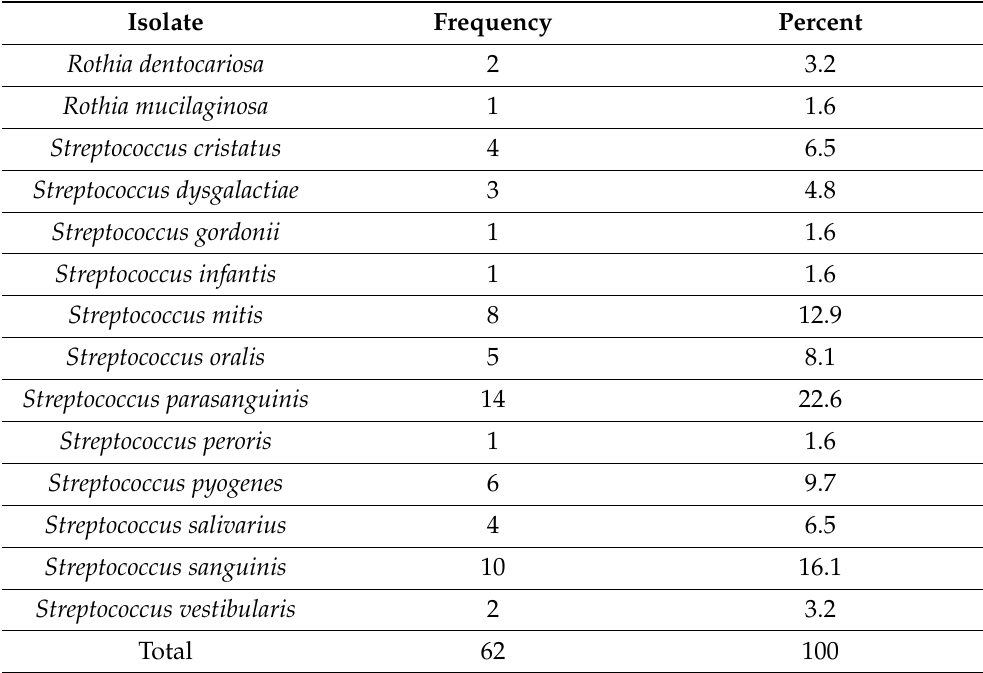
Table 2. Inhibitory isolates against pathogenic Neisseria